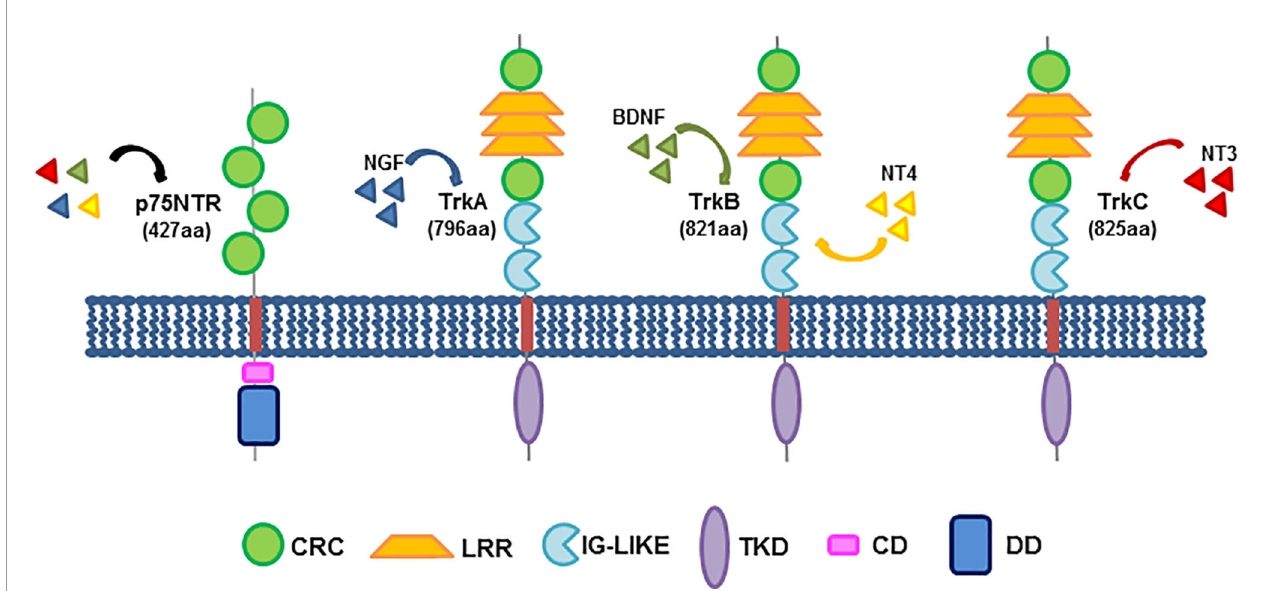
FIGURE 1 | Neurotrophin receptors and their structure. The three members of the Trk family share a common structure, encompassing a cysteine-rich cluster (CRC), three leucine-rich repeats (LRR), a second cysteine cluster and two immunoglobulin-like domains (IG-Like), responsible for ligand binding, in their extracellular domains. A transmembrane domain (TMD) anchors the receptor to the plasma membrane. The intracellular region consists of the tyrosine kinase domain (TKD). On the left, the low-af fi nity neurotrophin receptor, p75NTR (called NGFR) is also depicted. It consists of four cysteine-rich clusters in the extracellular domain, a transmembrane region and an intracellular region exhibiting a chopper domain (CD) and a death domain (DD). Shown beside each Trk member is reported the corresponding high-af fi nity binding neurotrophin. p75NTR might bind all neurotrophins at low af fi nity. The indicated domains are colored as follows: CRC, green; LRR, yellow; IG-Like, light blue; TMD, red; TKD, purple; CD, pink; DD, dark